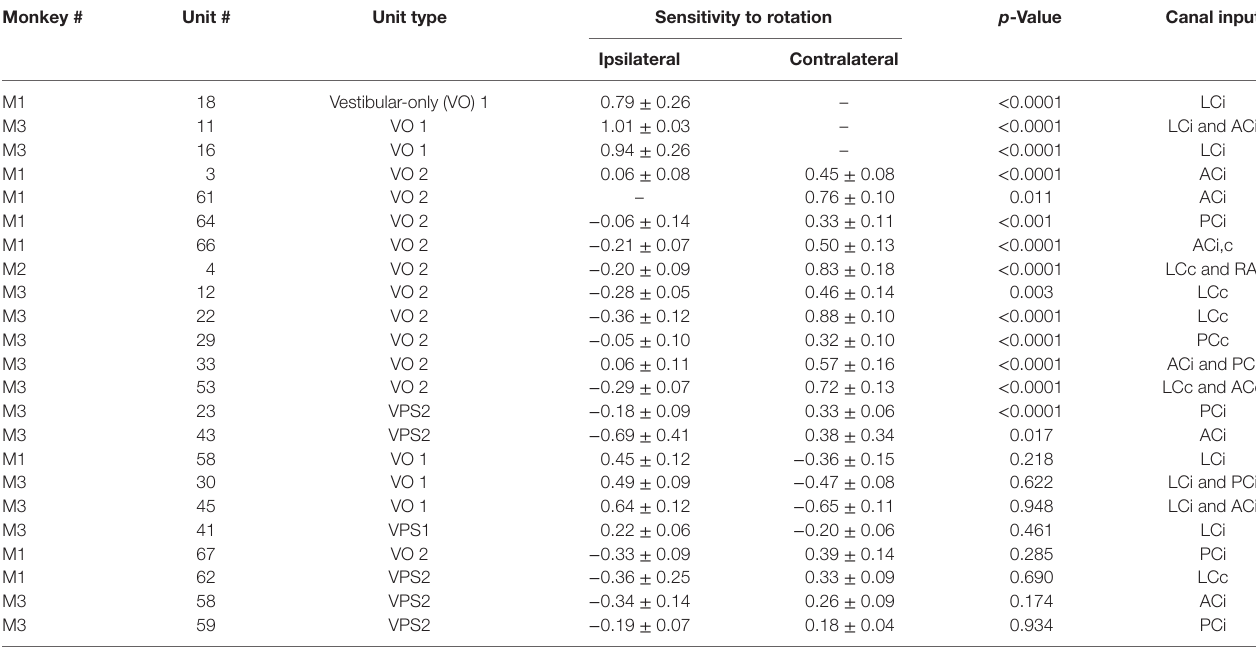
TaBle 1 | Neuronal sensitivity obtained by rotation with steps of velocity of 60°/s. Monkey